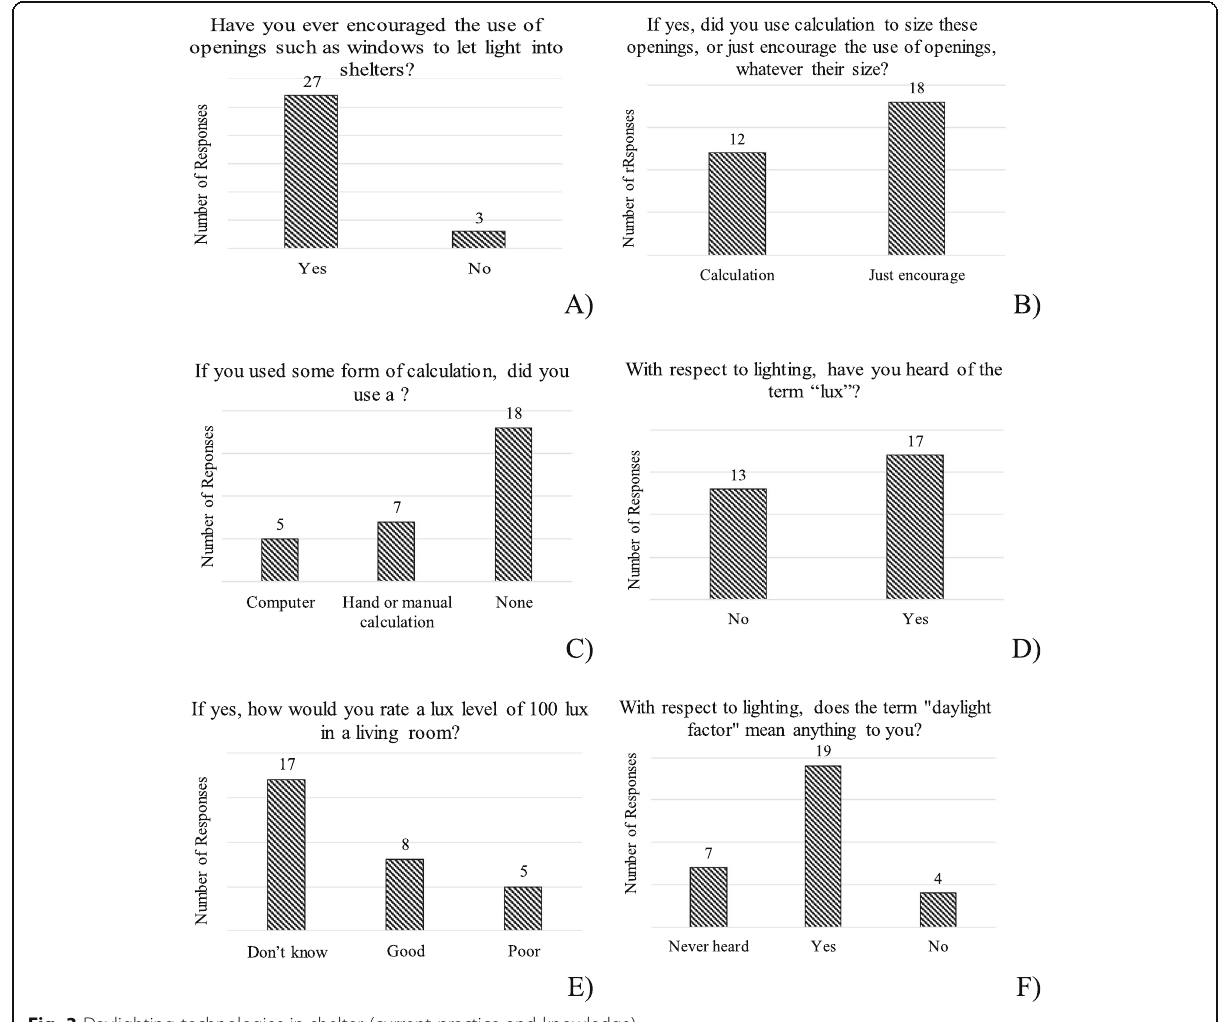
Fig. 3 Daylighting technologies in shelter (current practice and